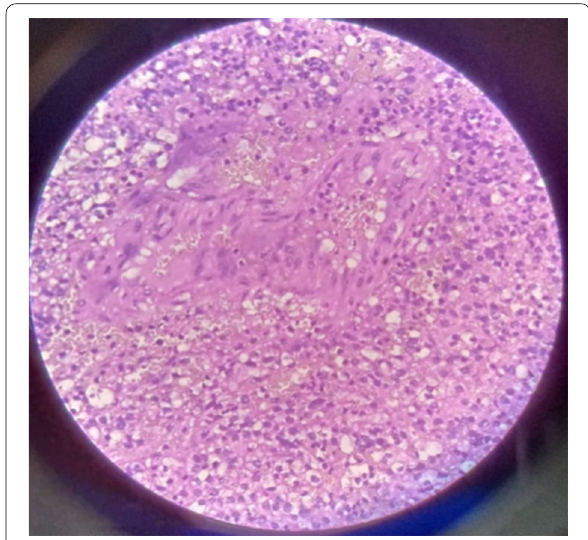
Fig. 4 Microscopic picture showing sarcomatoid